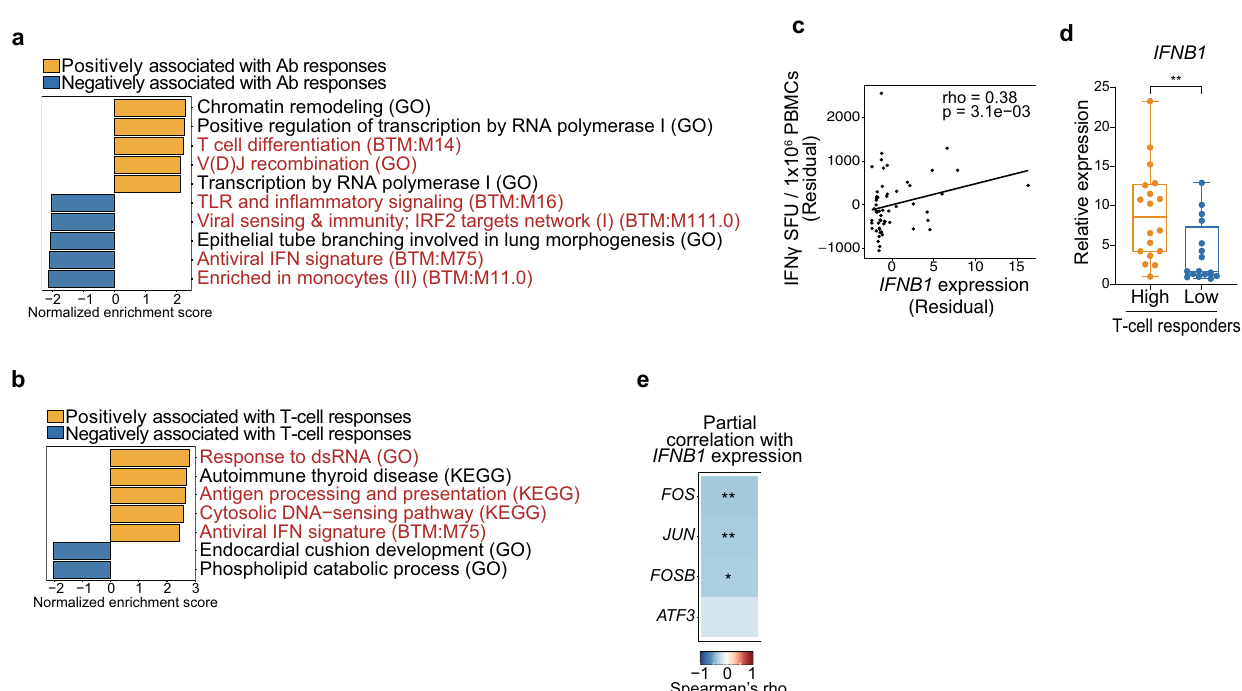
Fig. 4 Association between baseline FOS expression and ex vivo type I IFN responses induced by BNT162b2 mRNA. PBMCs collected from subjects ( n = 86) in the entire cohort at T1 were stimulated with BTN162b2 mRNA for 6 h and analyzed by bulk RNA-seq ( a – c , e ) or qPCR ( d ). a , b GSEA on a ranked gene list based on Spearman ’ s correlation coef fi cient between RNA expression and vaccine-induced antibody responses ( a ) or T-cell responses ( b ). Immune-related pathways are shown in red. c Correlation analysis between IFNB1 expression induced by ex vivo BNT162b2 mRNA stimulation and vaccine- induced T cell responses. d IFNB1 mRNA expression in high- ( n = 18) and low- ( n = 16) T-cell responders in the entire cohort was analyzed by qPCR. The P value was calculated with Wilcoxon signed rank test (** P < 0.01). Boxes show median and 25th – 75th percentiles, and whiskers show the range. e Correlation analysis between IFNB1 expression induced by ex vivo BNT162b2 mRNA stimulation and baseline expression of FOS , FOSB , JUN , or ATF3 . c , e Partial correlation analyses with adjustments for age and sex were performed with Spearman ’ s correlation tests with Benjamini – Hochberg FDR